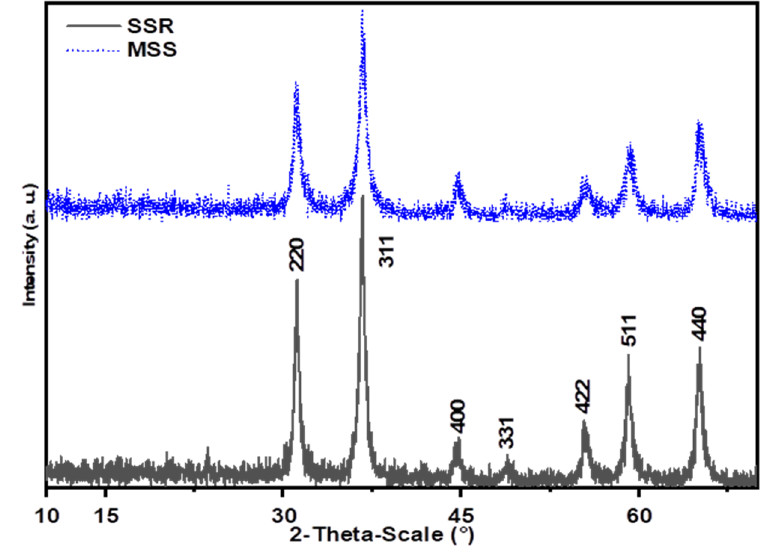
Fig. 3. XRD patterns of zinc aluminate samples synthesized by both SSR and